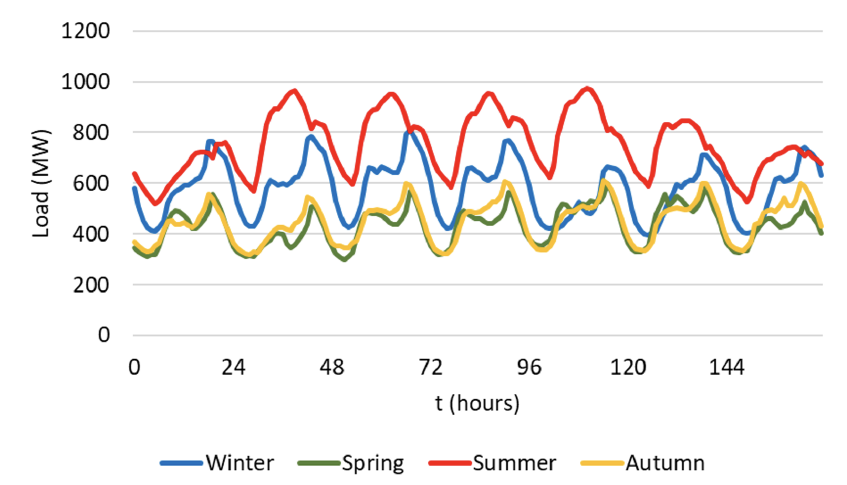
Figure 2. Weekly load demand per